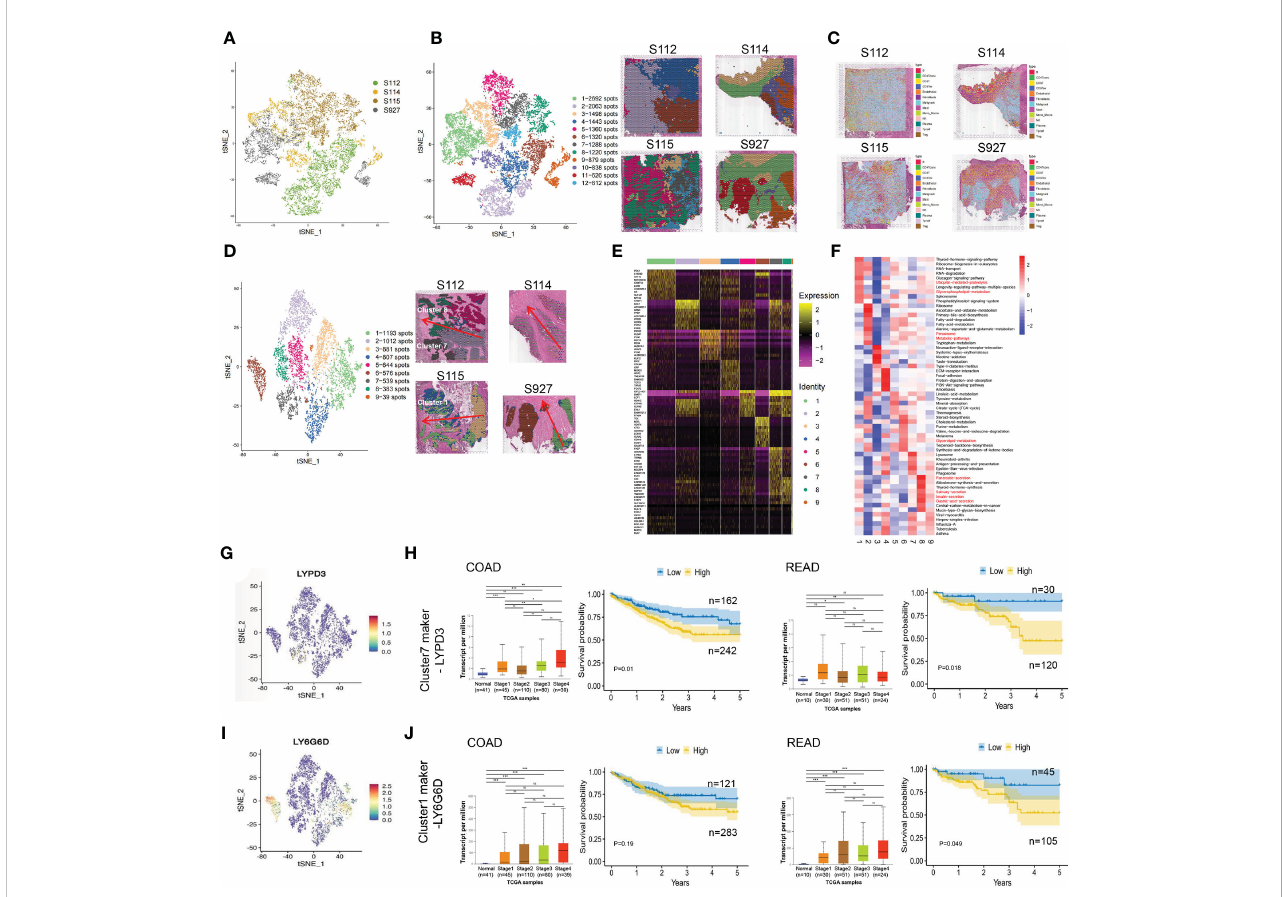
FIGURE 2 The clustering analysis of the cancerous region among the four CRC samples. (A) tSNE map showed the origin sites of different cell clusters from four CRC patients. (B) Dimensionality reduction and clustering of four samples. The left panel: tSNE map showed 12 different clusters in 4 CRC samples. The right panel: distribution of each cell cluster in tissues. (C) The spot map showed the composition of cell types identi fi ed in each spot on the sample slice. (D) Dimensionality reduction and clustering analysis of cancerous regions in the four CRC samples. Totally 9 clusters were identi fi ed. (E) Heatmap of the marker gene expression in the nine clusters. (F) Change of Signaling pathways in the nine clusters. The most obvious changed pathways along the progression were marked in red. (G) tSNE map showed the spatial distribution of cluster7 maker gene LYPD3 in four CRC tissues. (H) The relationship of LYPD3 expression level and cancer stage/ progression-free survival in colon cancer (left) and rectal cancer (right) from TCGA database. (I) tSNE map showed the spatial distribution of cluster1 maker gene LY6G6D in four CRC tissues. (J) The relationship of LY6G6D expression level and cancer stage/progression-free survival in colon cancer (left) and rectal cancer (right) from TCGA database.*P < 0.05, **P < 0.01 and ***P < 0.001. NS, not signi fi cant